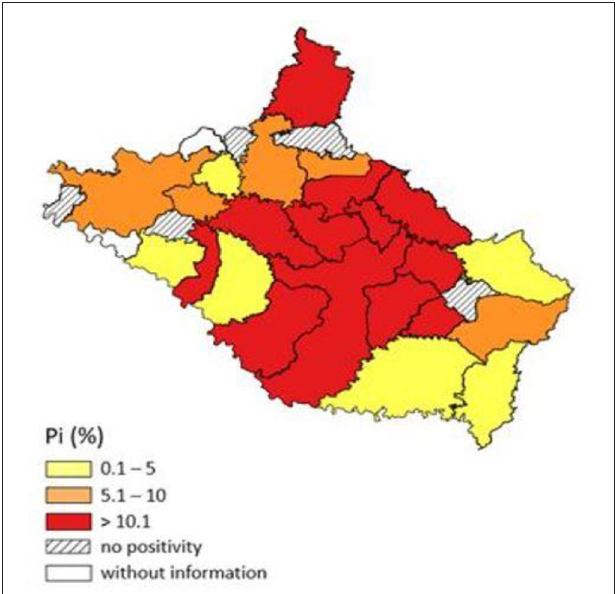
FIGURE 2 | Map of the distribution of the bovine fasciolosis positivity index from 2018 to 2021 according to data from three slaughterhouses under the State Inspection Service in 28 municipalities in the Serrana Mesoregion of Santa